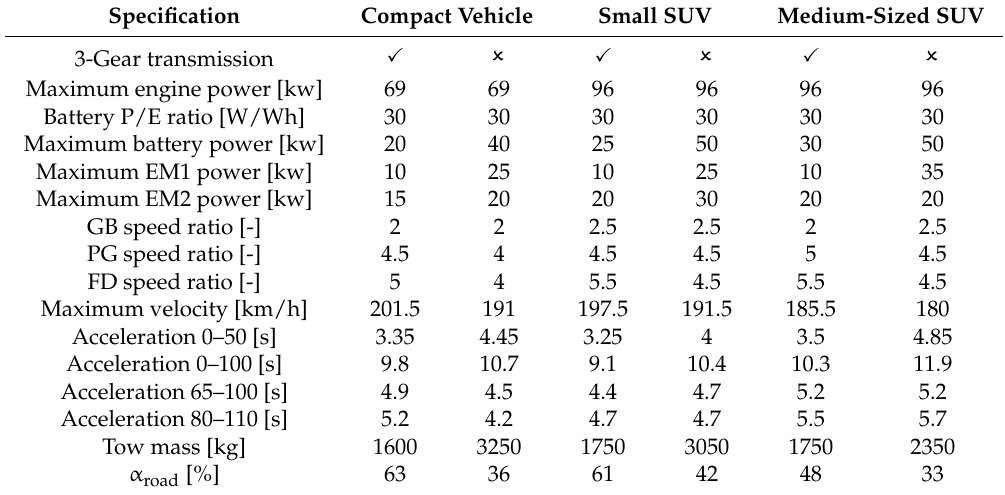
Table 12. Design component specifications and actual performance of the six optimized vehicles.